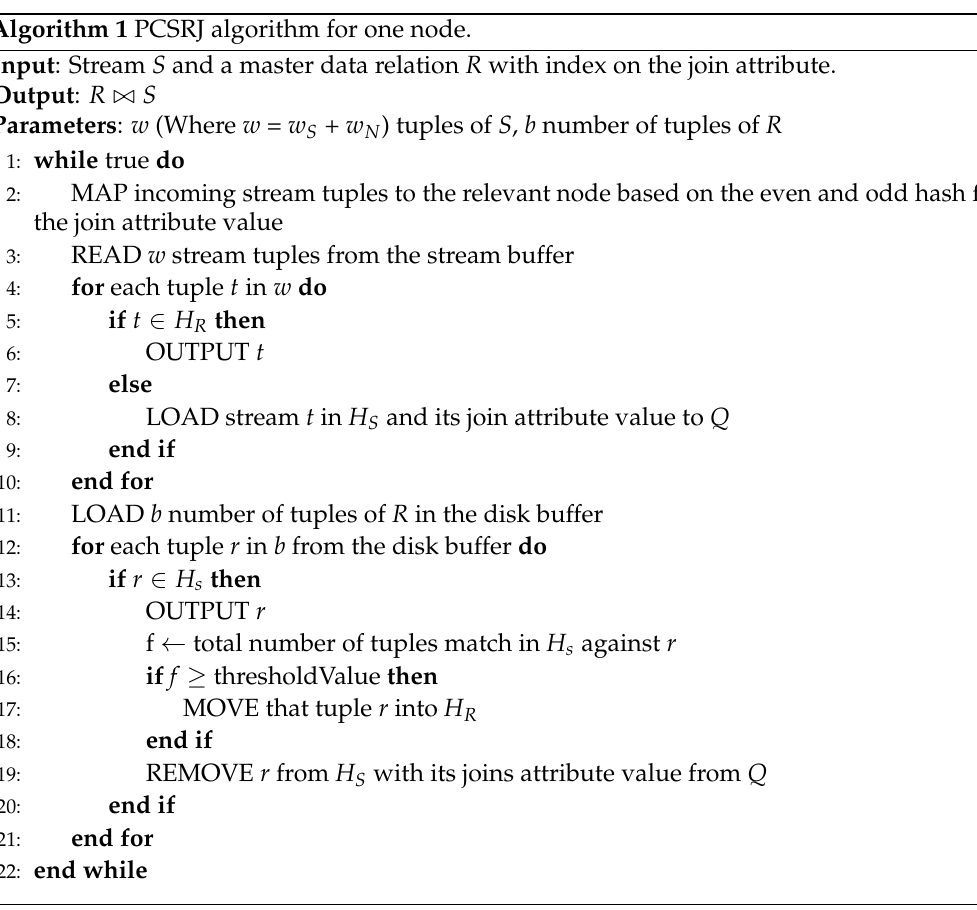
Algorithm 1 PCSRJ algorithm for one